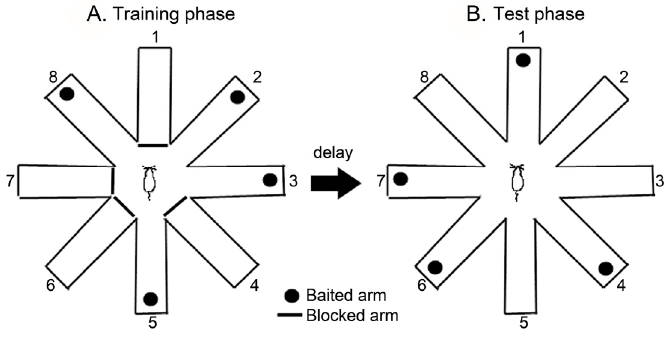
Figure 2. The schematic diagram of the eight-arm radial maze. The animals were tested in the RAM with a 5 min delay. with a 5 min